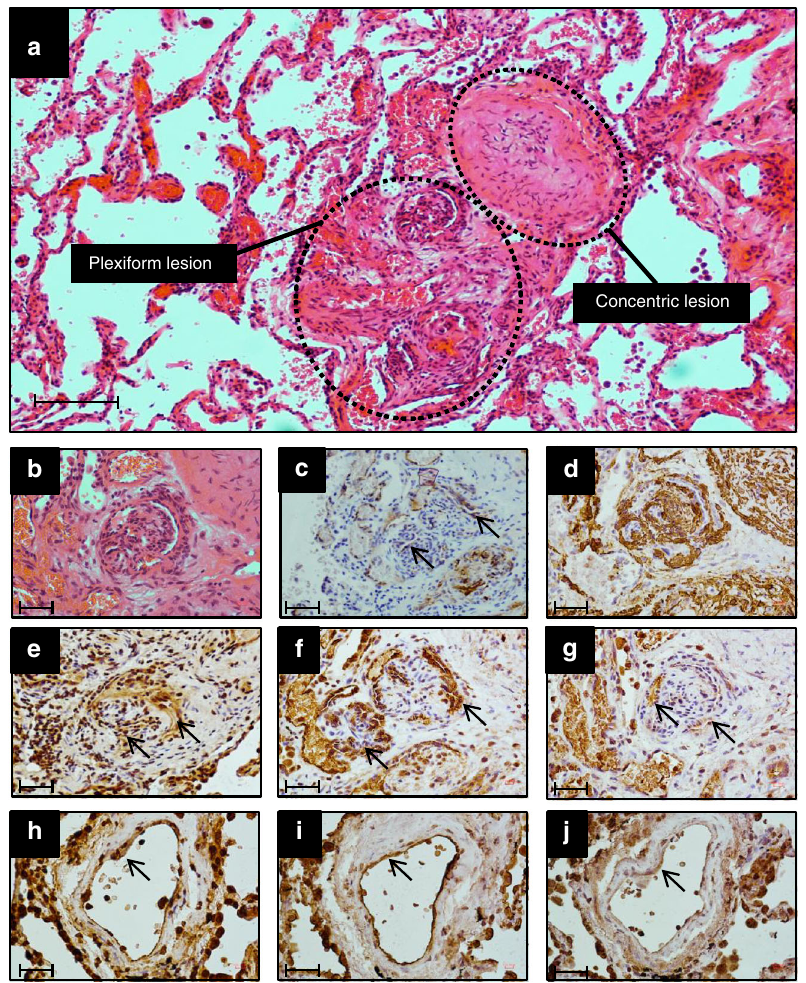
Fig. 9 Immunolocalisation of AQP1, ATP13A3 and SOX17 in normal and PAH lung. The typical histological fi ndings (haematoxylin and eosin staining) of concentric vascular lesions with associated plexiform lesions are shown ( a ). Higher magni fi cation images of plexiform lesion ( b ), with frequent endothelialised channels ( c ; anti-CD31) surrounded by myo fi broblasts ( d ; anti-SM α ). Additional high magni fi cation images demonstrating endothelial expression of ATP13A3 ( e ), AQP1 ( f ) and SOX17 ( g ) in PAH lung. Controls lung sections demonstrating predominantly endothelial expression of ATP13A3 ( h ), AQP1 ( i ) and SOX17 ( j ). (Scale bars = 50 µ